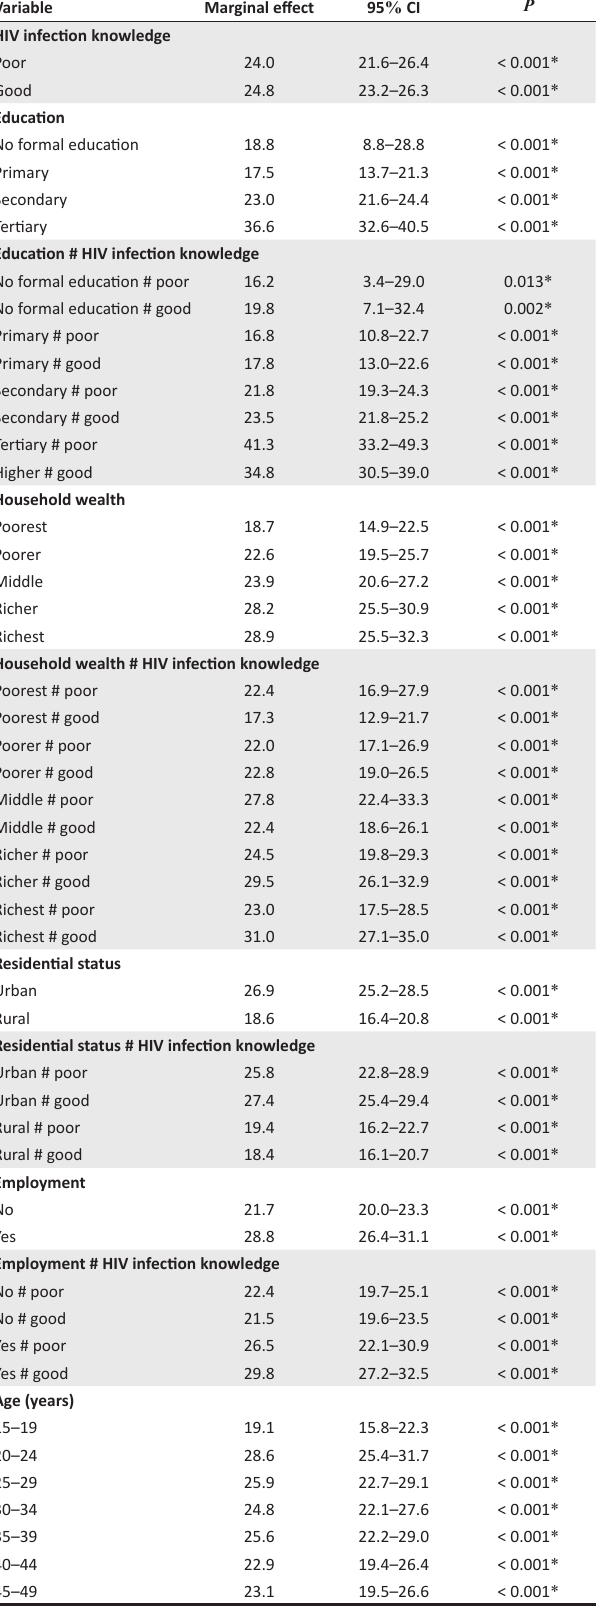
TABLE 1-A1: Marginal interaction effect of HIV self-testing knowledge amongst South African women. Variable Marginal